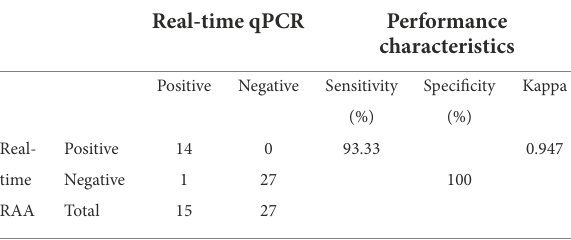
TABLE 3 Comparison of the results of real-time RAA assay and qPCR method for clinical